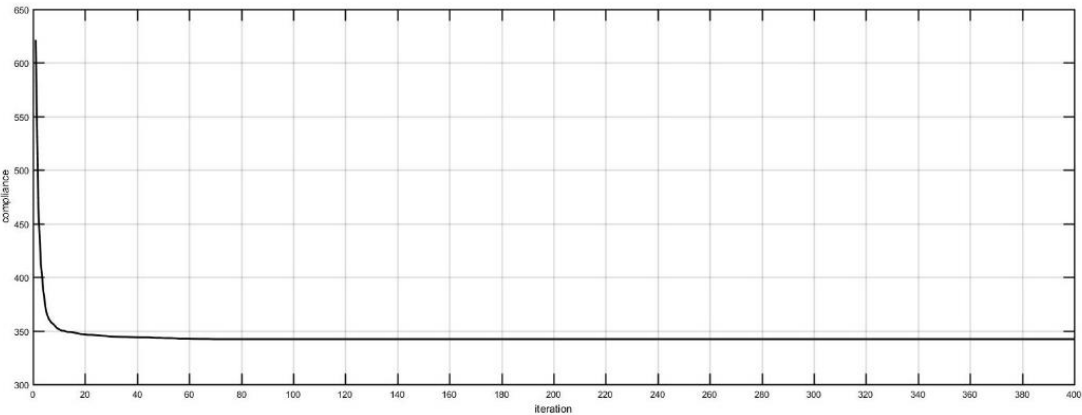
Figure 3. Optimization results at different stages.